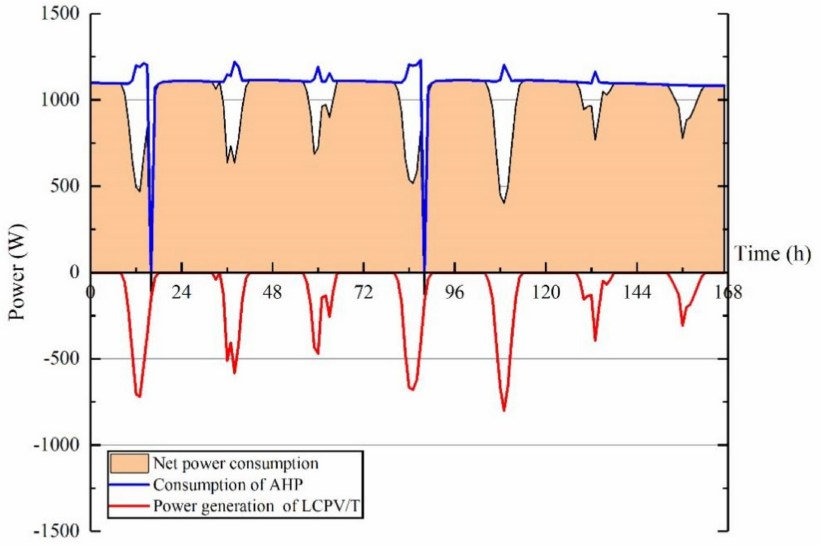
Figure 9. Weekly power generation and consumption of the